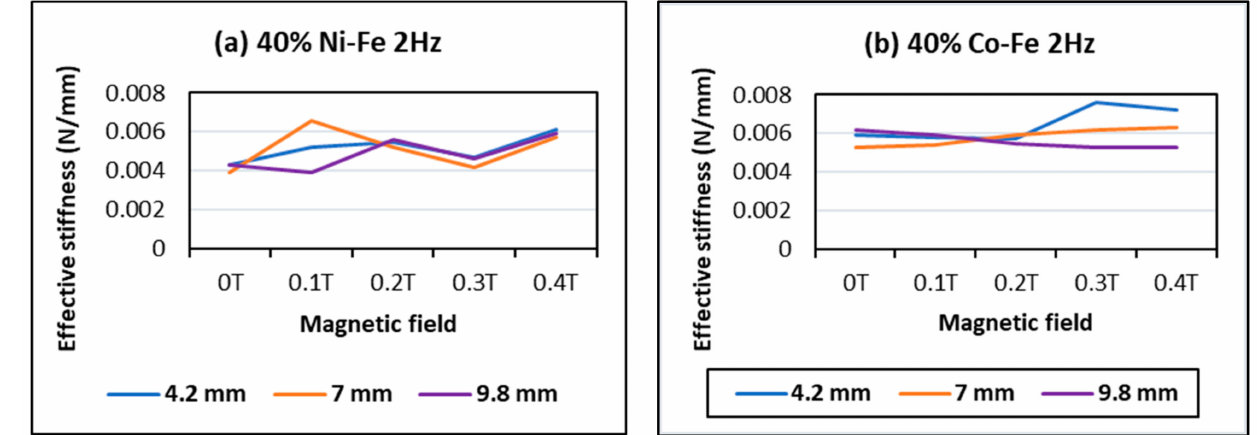
Figure 14. Effect of flux and displacement amplitude on effective stiffness of ( a ) 40% Ni-Fe MRE compared with ( b ) 40% Co-Fe